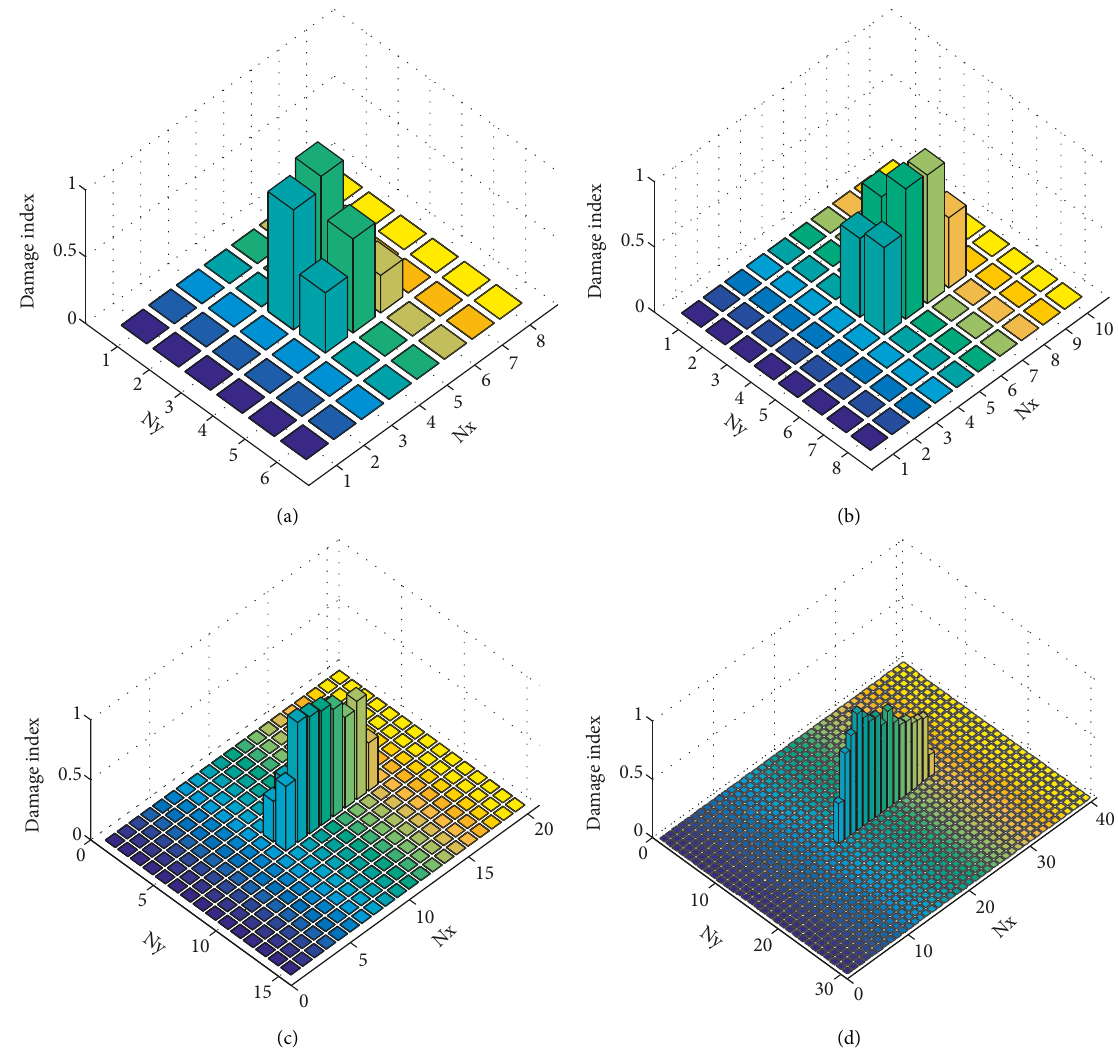
ij : (a) Mesh 5%, (b) Mesh